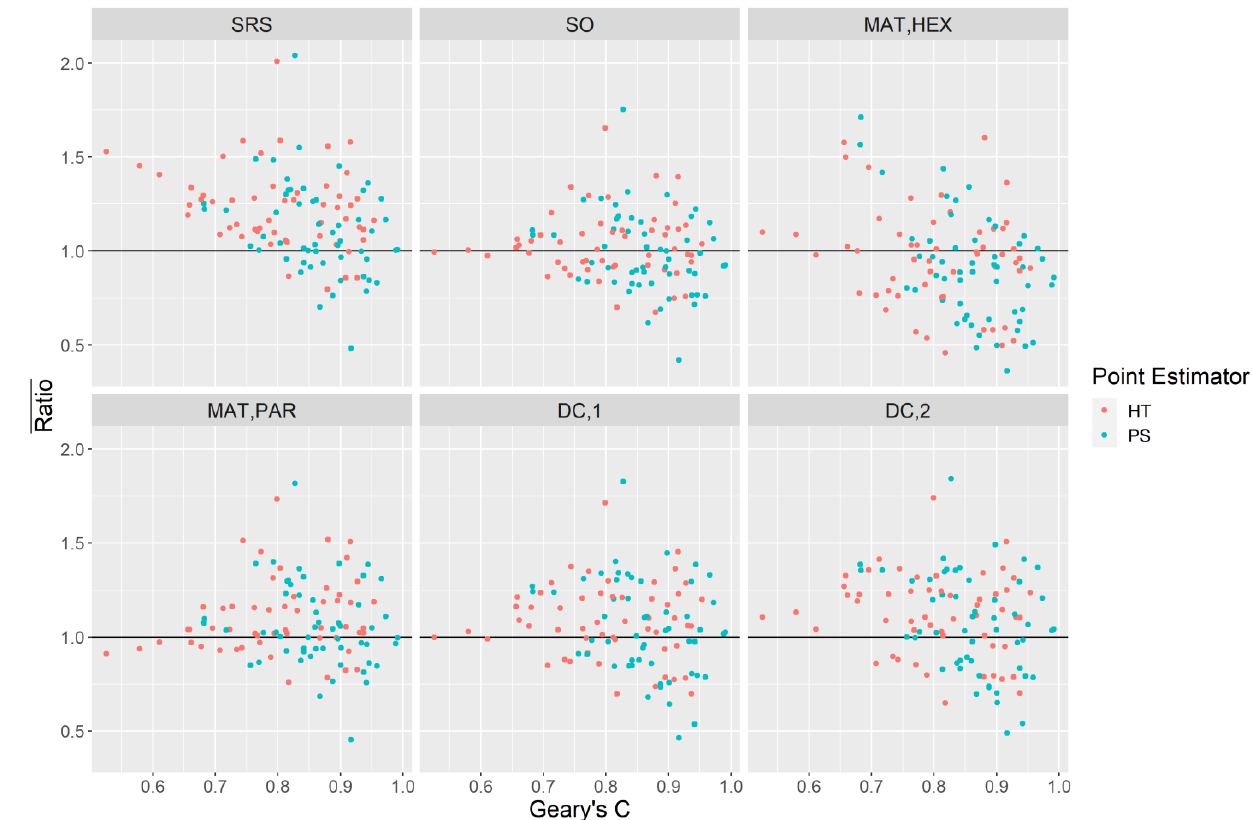
Figure 5. 𝑅𝑎𝑡𝑖𝑜̅̅̅̅̅̅̅̅ for all species-specific attributes considered for the large domain under HT and PS point estimators for all variance estimators. Each point represents 𝑅𝑎𝑡𝑖𝑜̅̅̅̅̅̅̅̅ for one species-specific attribute under a specific point estimator and variance estimator.